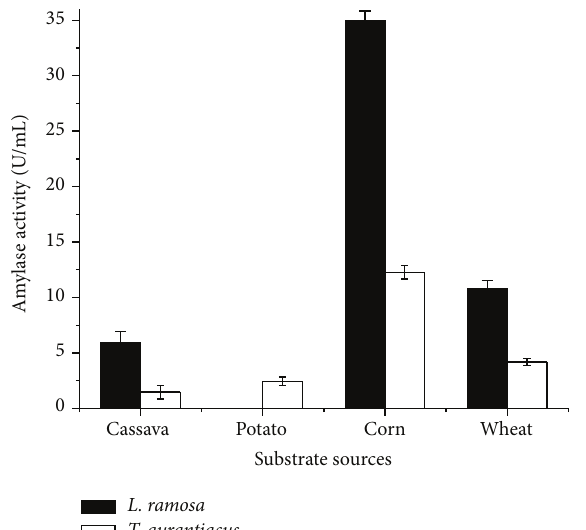
Figure 4: Enzymatic hydrolysis of starch derived from several vegetal sources (DNS method) (each data point was the average of two replicate determinations, and the error bars show the data ranges).